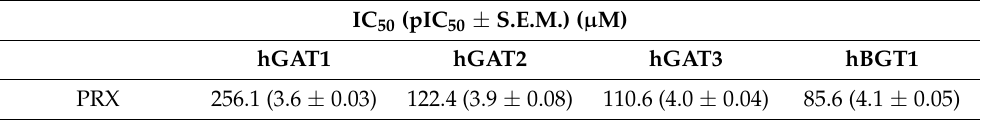
Table 3. Inhibitory activity of PRX at hGAT1-3 and hBGT1 stably expressed in CHO cells using the [ 3 H]GABA uptake